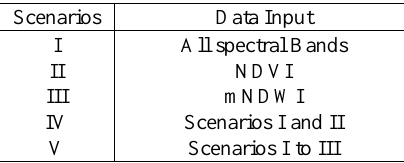
Table 2. Experimental scenarios